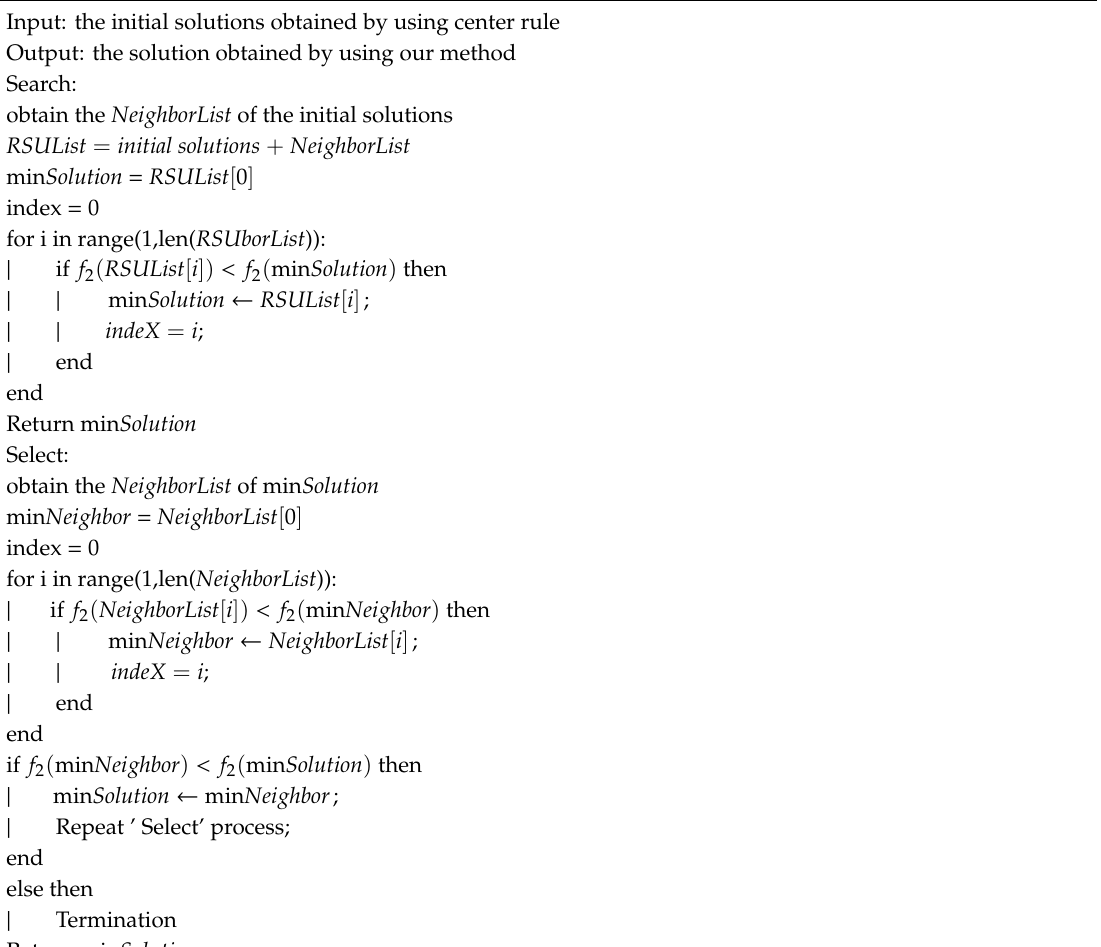
Algorithm 2 Neighborhood Search Algorithm: pseudocode for obtaining the RSUD